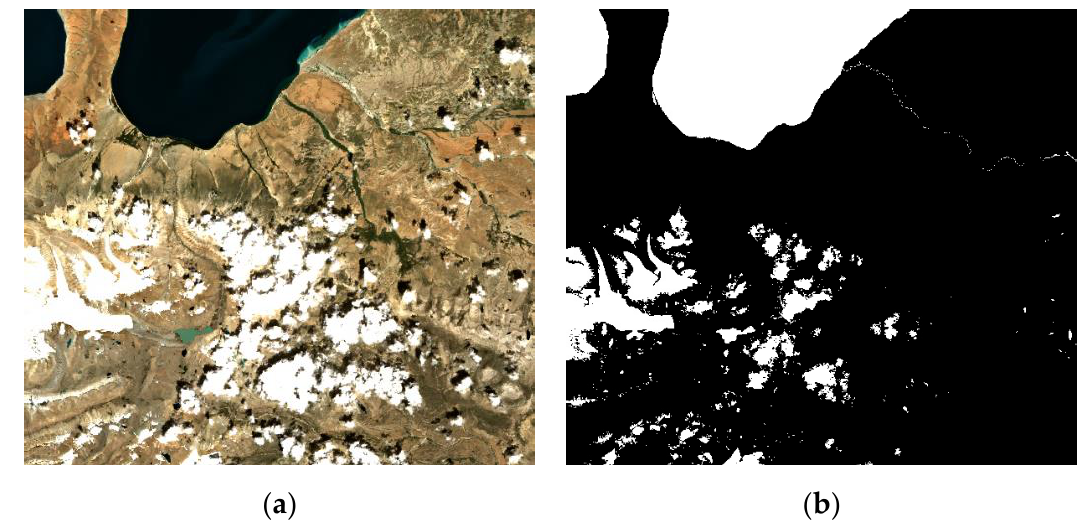
Figure 3. ( a ) True-color (red–green–blue) composite of Sentinel-2 image; ( b ) pixels that were identified as water.